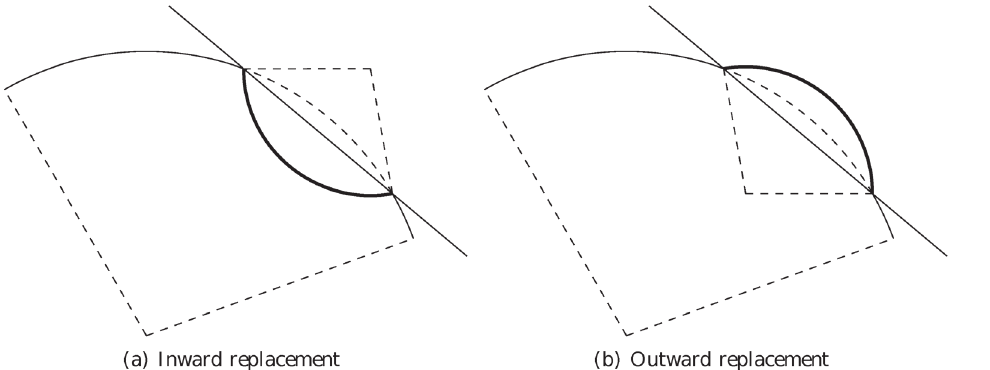
Fig 1. The replacement of an arc segment in the arc-fractal system. The line passing through the two end points of the arc segment is to determine the orientation of the new arc.